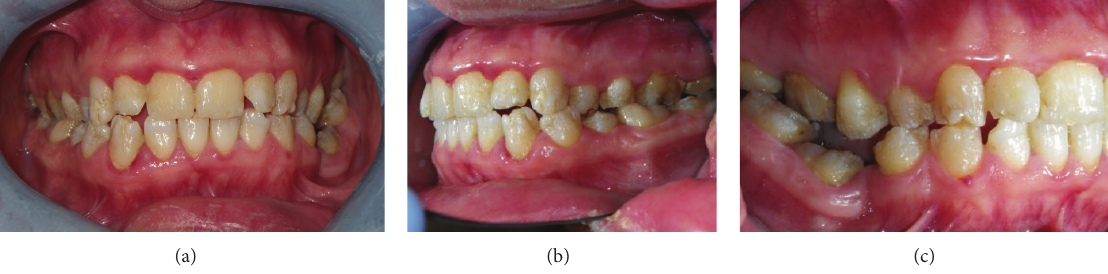
Figure 4: Intraoral aspects of a patient with JEB (generalized enamel hypoplasia).